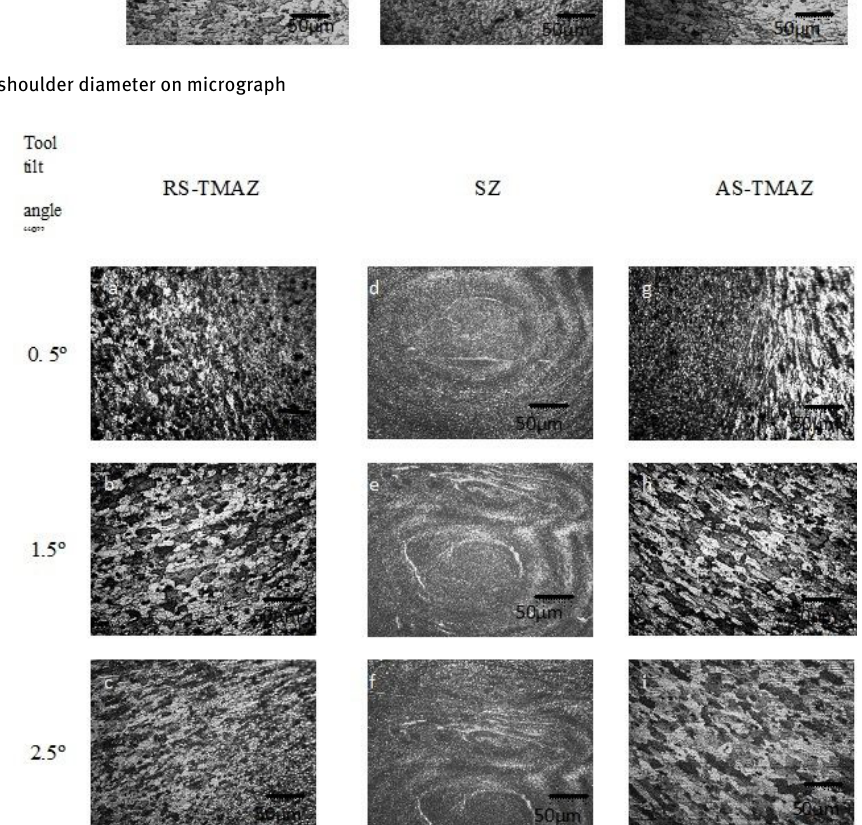
Figure 19: Effect of tool tilt angle on